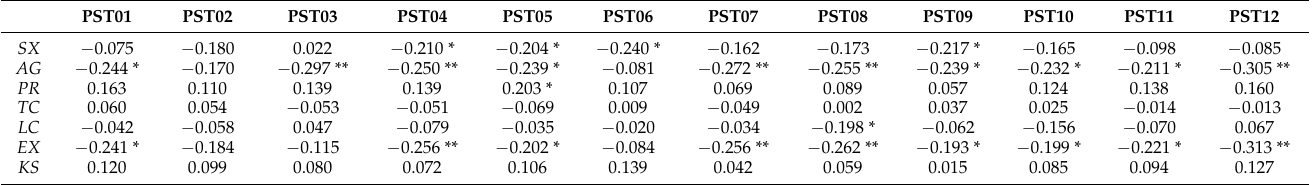
Table A2. Spearman correlation matrix: knowledge of problem solving